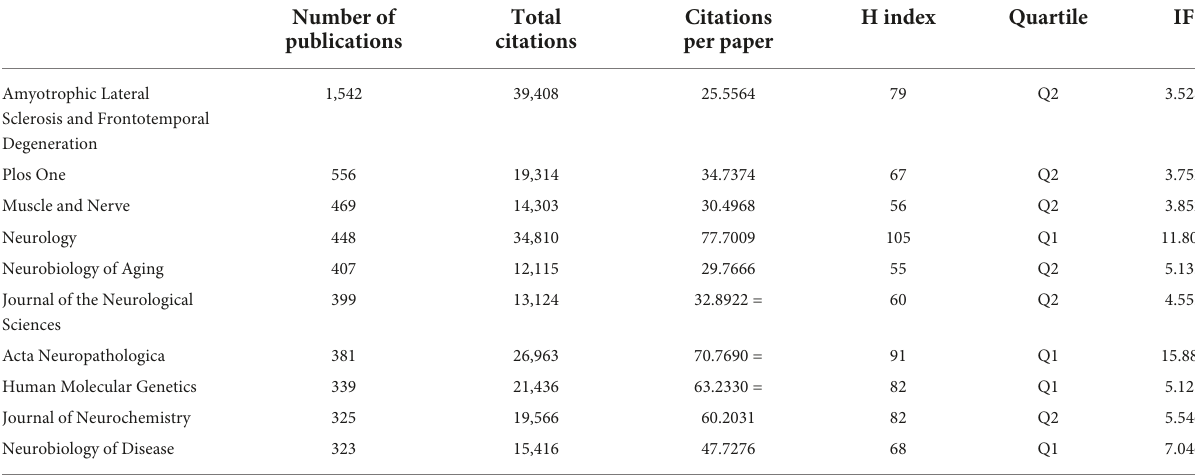
TABLE 5 Overview of top 10 most productive journals in ALS